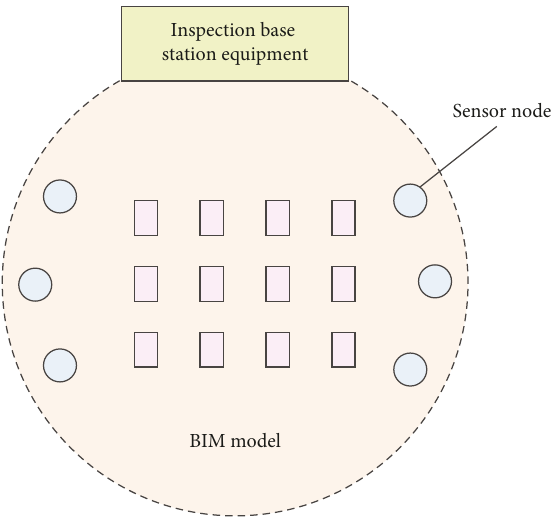
Figure 3: Structure block diagram of a seismic detection system based on BIM